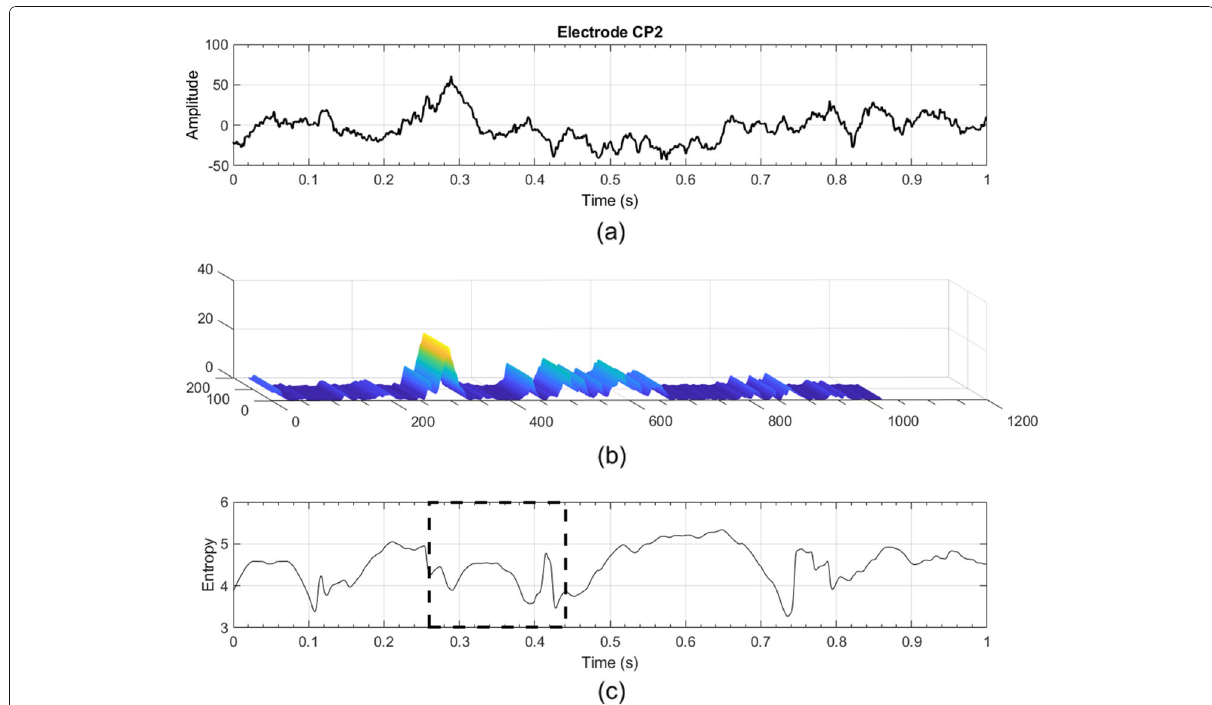
Fig. 17 Electrode CP2 after RICI . a Time domain representation of ERP. b SPWVD time-frequency representation. c Short-term Rényi entropy of the distribution